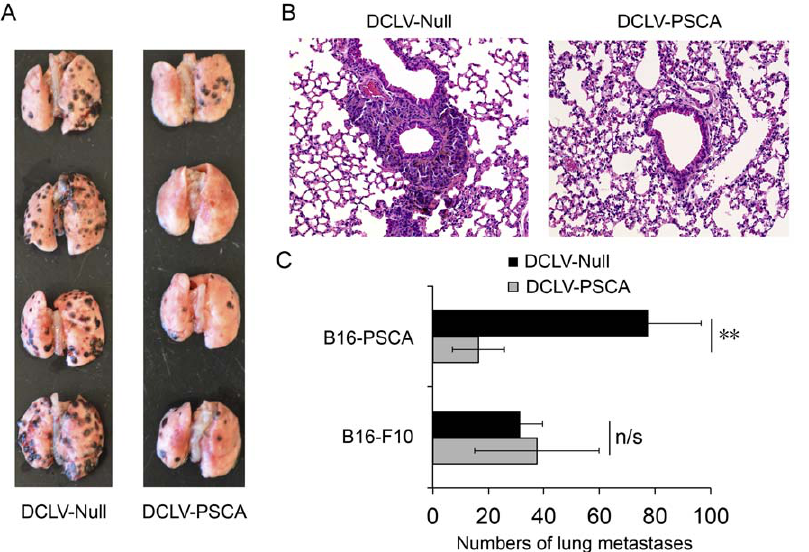
Figure 5. The ability of DCLV-PSCA immunization to suppress lung metastases. (A) Male C57BL/6 mice were immunized with DCLV-PSCA or DCLV-Null as a mock control. Ten days later, mice were challenged with 0.2 million B10-F10-PSCA cells by intravenous injection through tail vein. Two weeks later, mice were sacrificed, and macroscopic views of the lungs were shown. (B) Microscopic H&E staining (20 6 ) of lung tissue samples from mice immunized with DCLV-PSCA or DCLV-Null. (C) Statistical quantification of melanoma lung metastases (number of black nodules on the lungs) of immunized mice; similar immunization, but with the original B16-F10 melanoma metastases included as a control. (**: P , 0.01 and n/s: not statistically significant; One-way ANOVA followed by Bonferroni’s multiple comparison test. Error bars represent SD, n=4). All experiments were repeated twice and the representative data is shown.